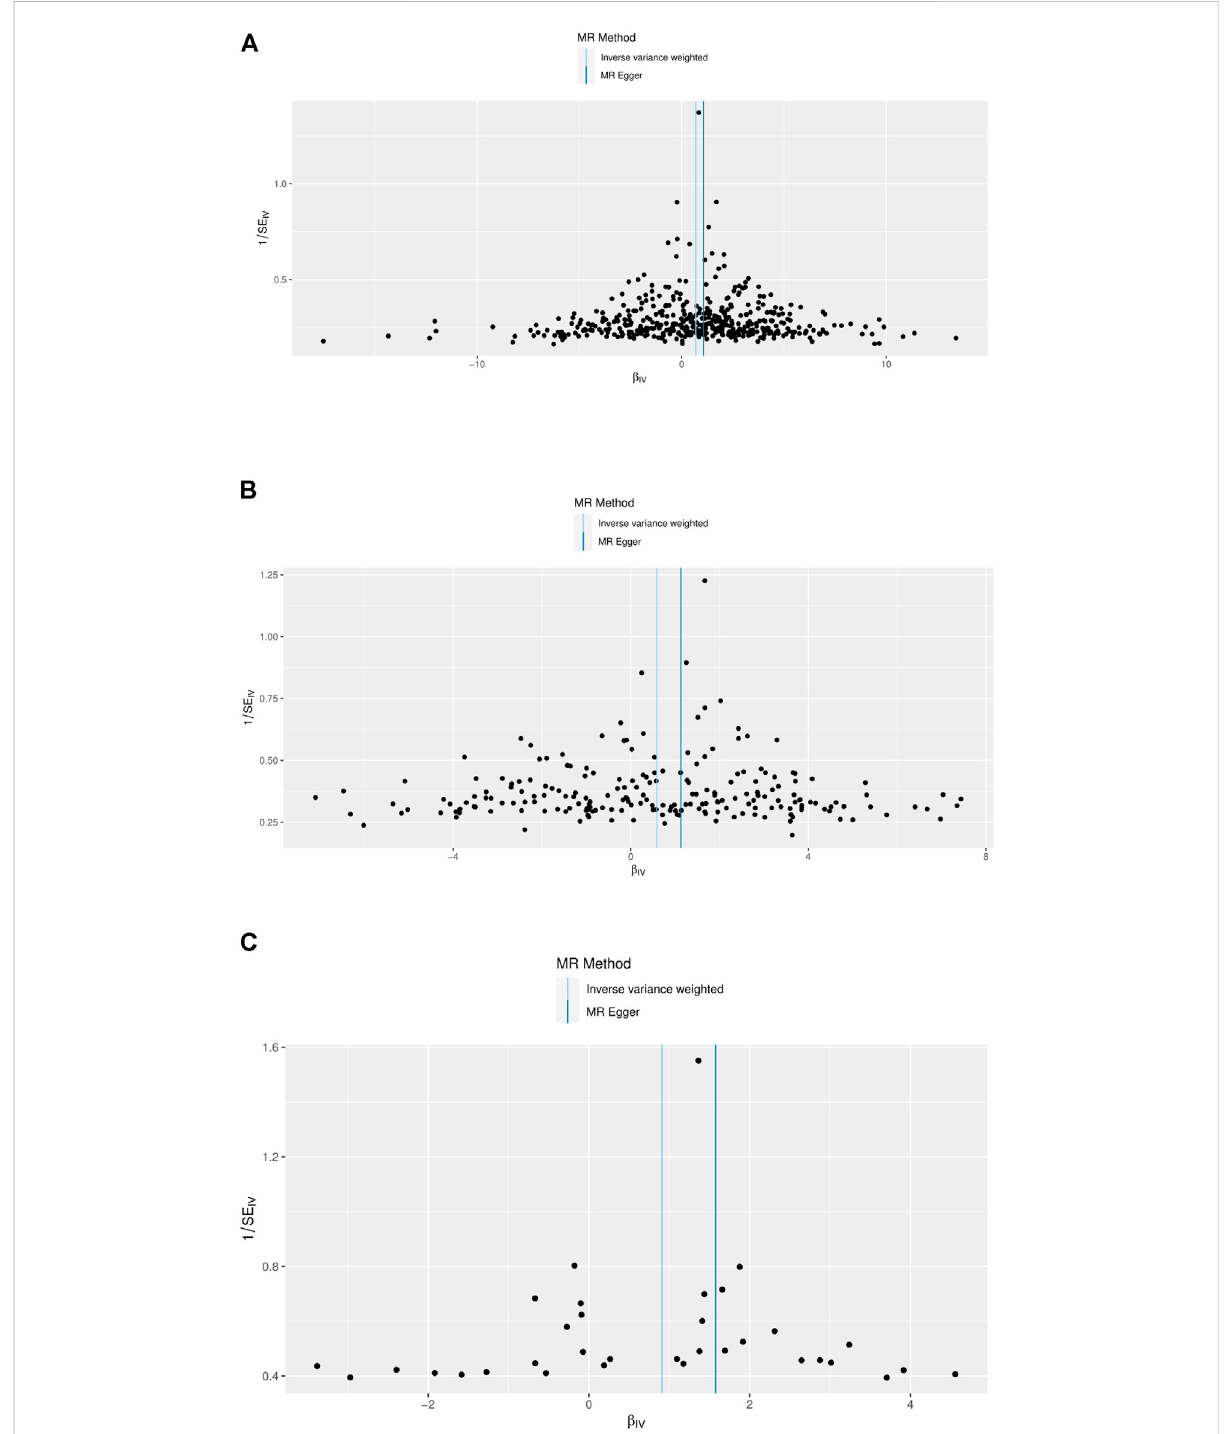
Funnel plots to visualize overallheterogeneityof MRestimates forthe effectof BMI, trunk fatmass,and WC onDKD. (A) Causal effect ofBMIon DKD. (B) Causal effect of trunk fat mass on DKD. (C) Causal effect of WC on DKD. IVW, inverse-variance weighted; MR, Mendelian